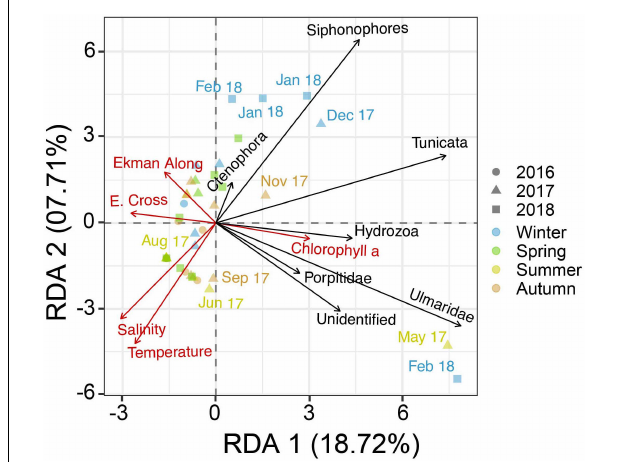
FIGURE 2 | Redundancy Analysis (RDA) triplot showing the differences between the biovolume of the gelatinous zooplankton communities sampled, the directionality and relative strength of the relationship between environmental drivers, taxa occurrence, and the differences between sampling events for the RDA axes 1 and 2. Arrow scaling is proportional to